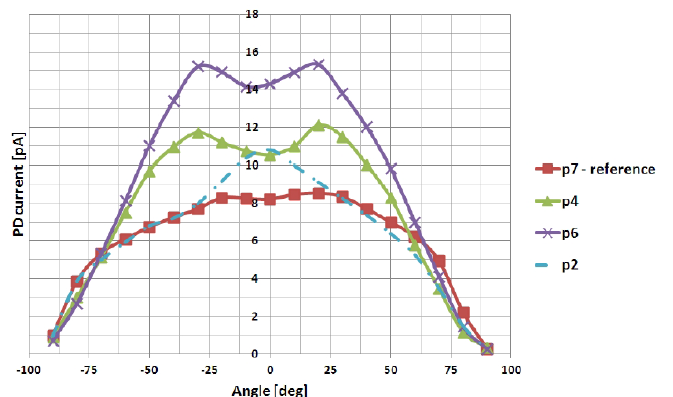
Figure 1. Angular distribution of extracted photons from three photonic crystals deposited on an LSO ( LuSiO ) crystal (P2, P4 and P6) as compared to the rather flat LSO reference (P7)